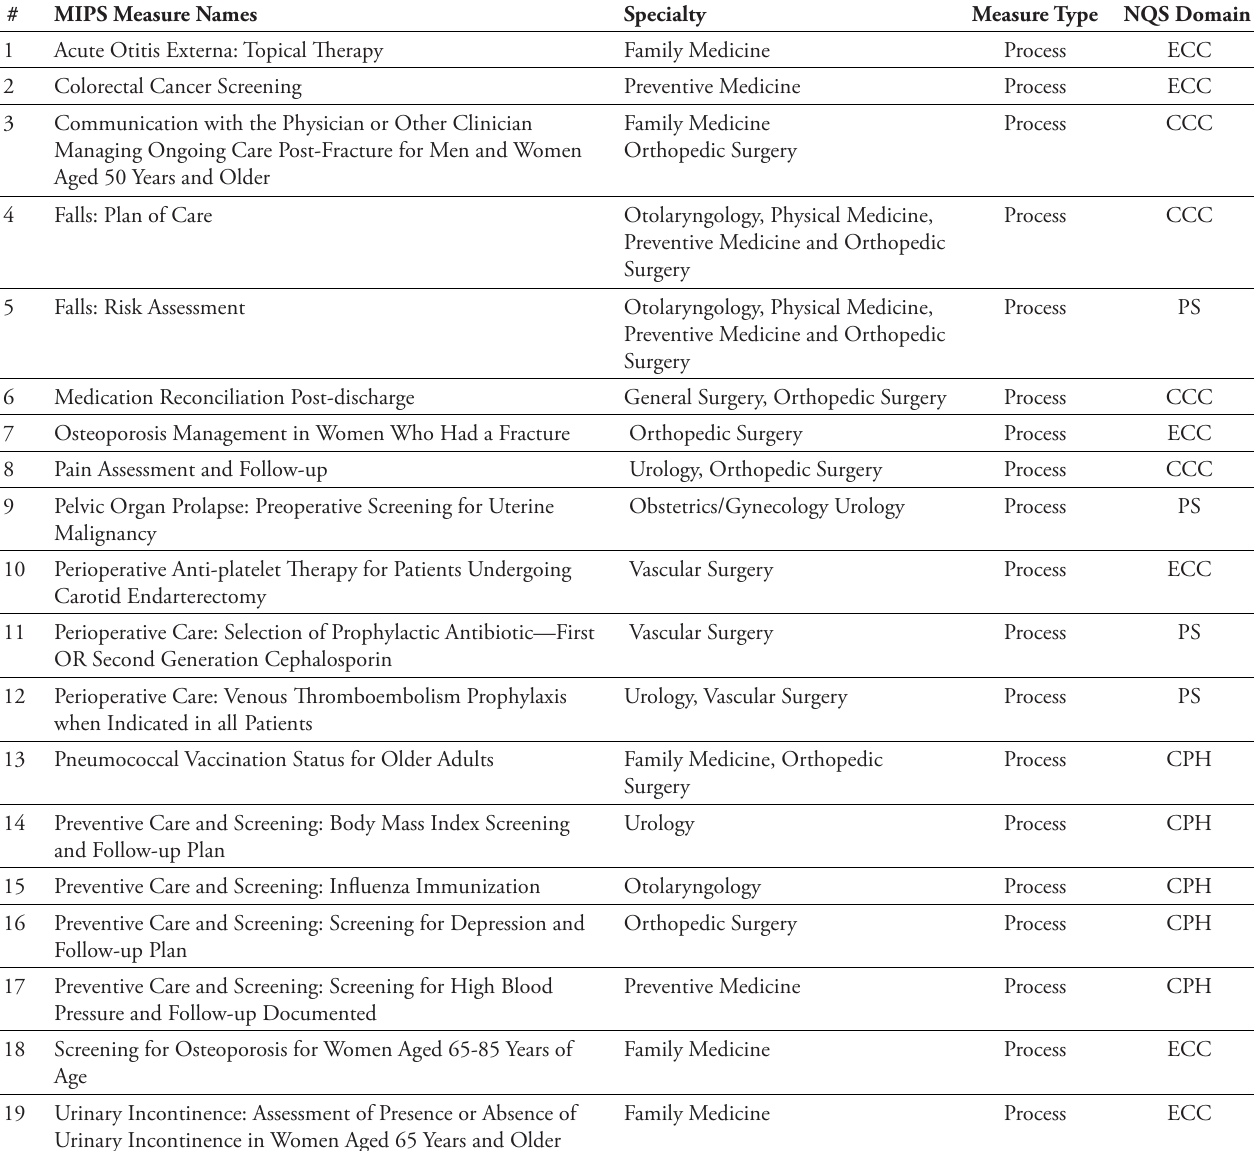
Table 7. Examples of Additional 2018 MIPS Measures Compared to